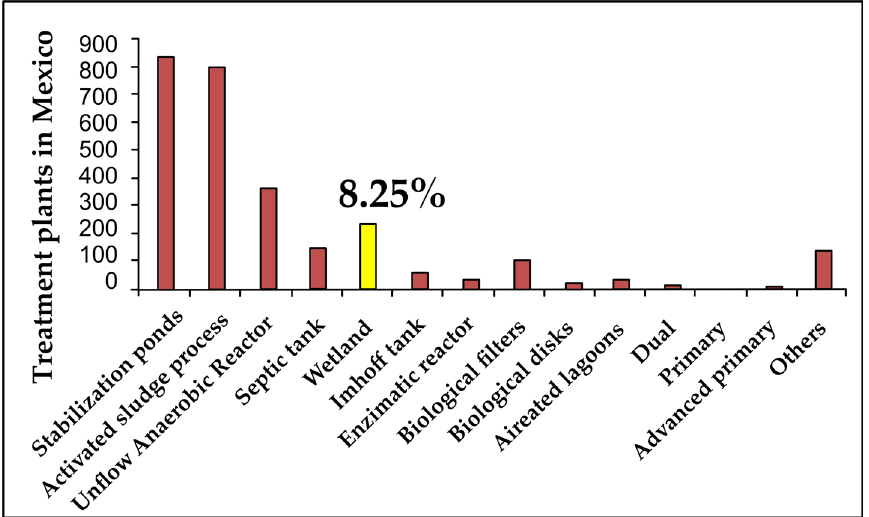
Figure 2. Municipal wastewater treatment plants in Mexico. Elaborated with data from CONAGUA [12].